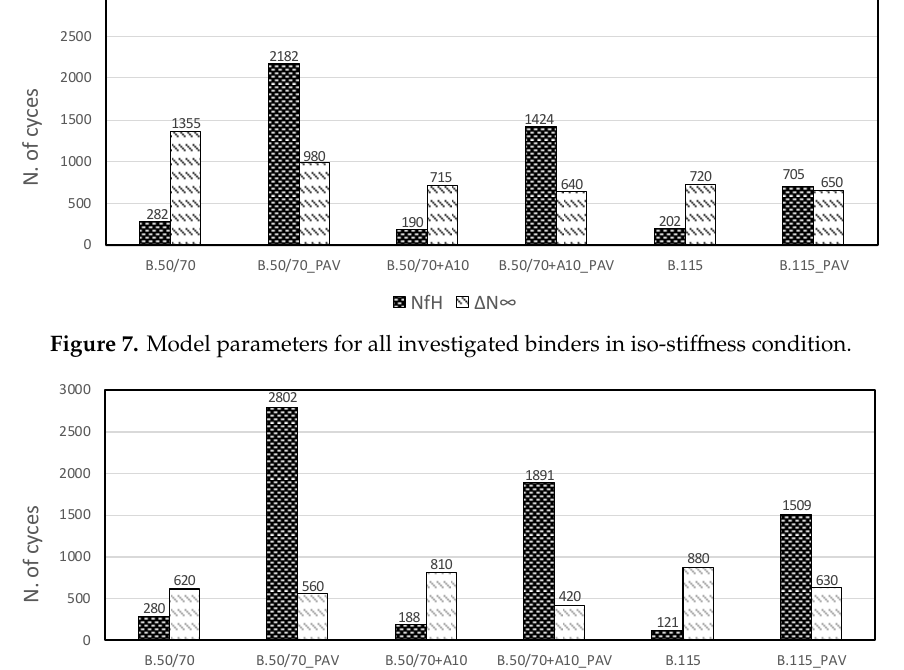
Figure 7. Model parameters for all investigated binders in iso-stiffness condition.